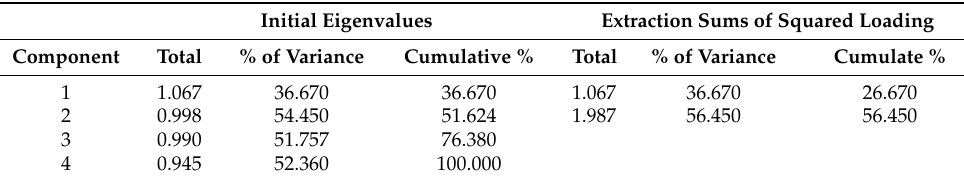
Table 4. Example of percentage of explained